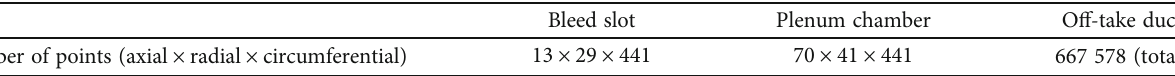
Table 3: Numbers of grid points used for bleed system. Bleed slot O ff -take duct Number of points ( axial × radial × circumferential